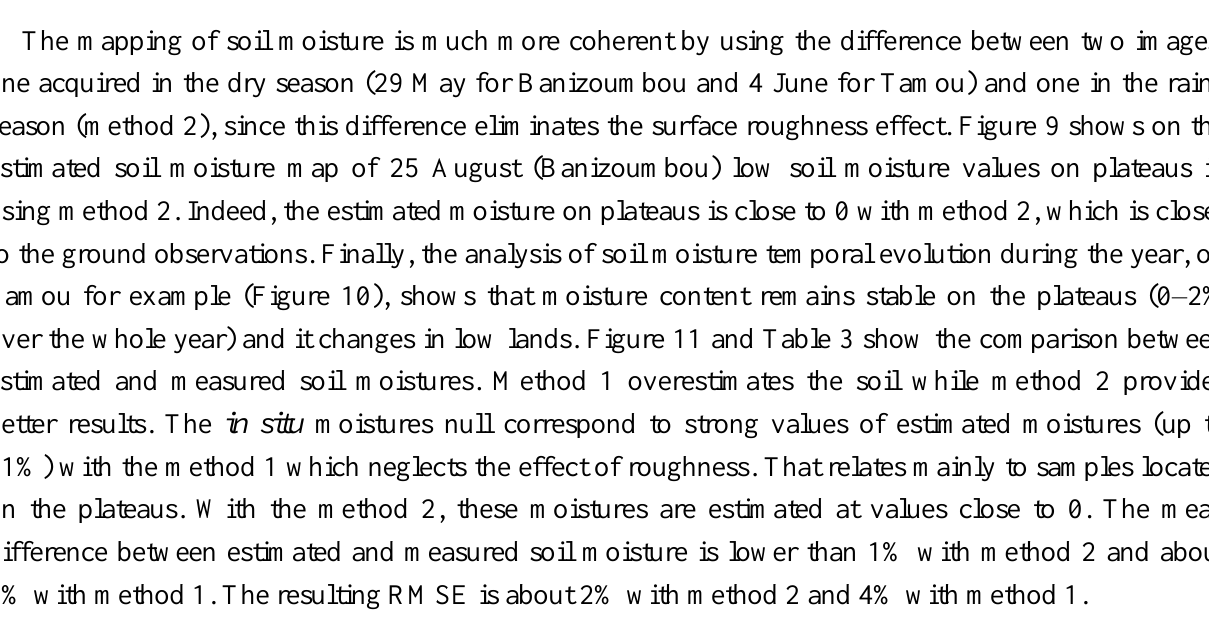
Figure 9. Result of soil moisture mapping in using methods 1 and 2 on August 25 (cells of 500 × 500 pixels). The image covers 10 km × 10